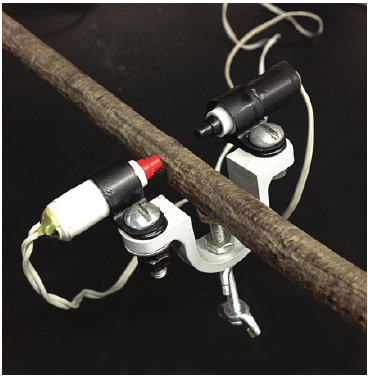
Figure 1: Infrared activity